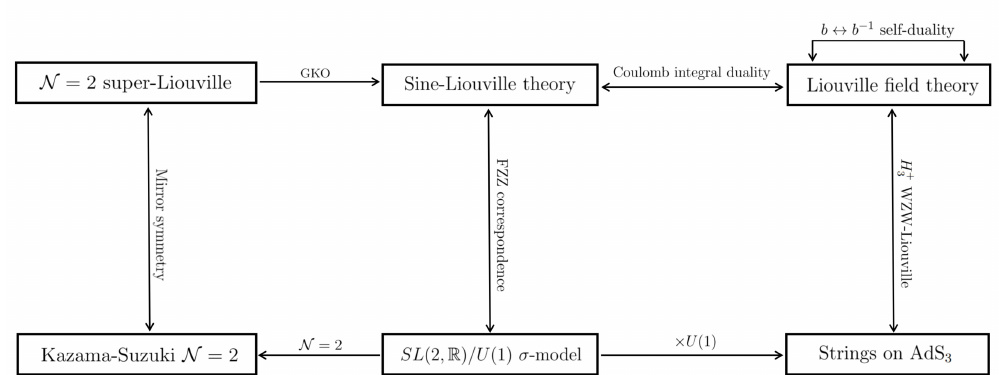
Figure 1 . Scheme of different (duality) relations among CFTs. The FZZ correspondence relates sine-Liouville theory with the SL(2 , R ) / U(1) coset σ -model that describe string theory on the Eu- clidean 2D black hole. The latter model can be used to describe string theory on AdS 3 , since the spectral flow sectors of the SL(2 , R ) WZW theory are conveniently realized in terms of the product SL(2 , R ) / U(1) × U(1) . The latter theory also relates to the standard Liouville theory by the H + WZW-Liouville correspondence. Finally, the sine-Liouville correlators can be written as integrated Liouville correlators due to remarkaby identities among conformal